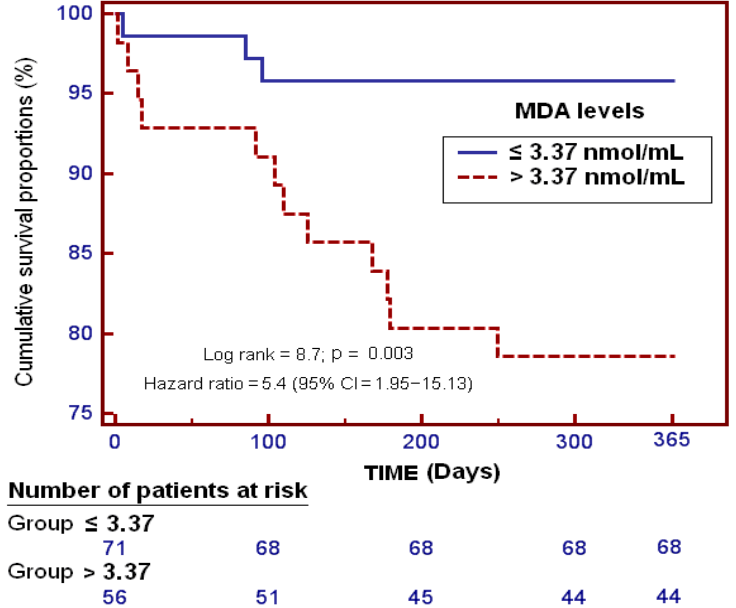
Figure 3. Survival curves at 1 year in patients undergoing liver transplantation for hepatocellular carcinoma using serum MDA levels higher or lower than 3.37 nmol/mL.